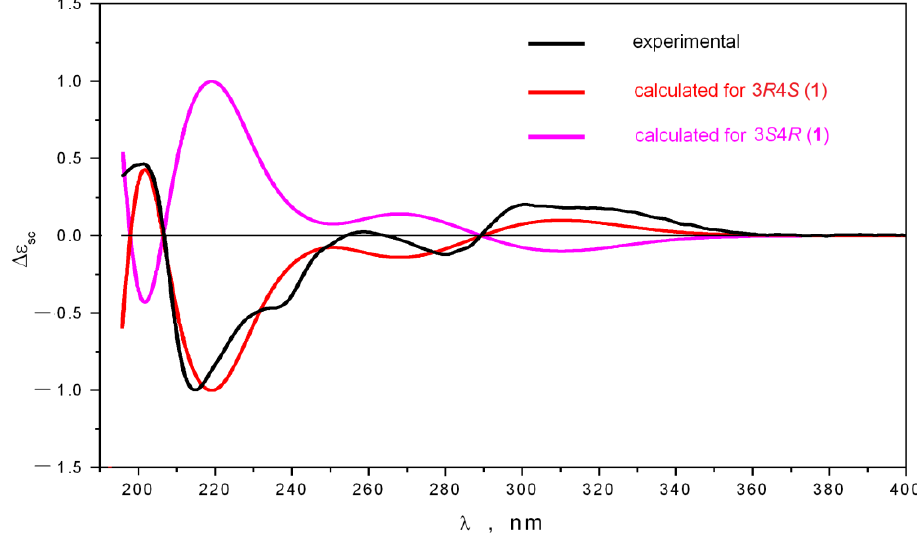
Figure 3. The comparison of the experimental ECD spectrum of 1 with the spectra calculated for the 3 R 4 S and 3 S 4 R stereoisomers of 1 .